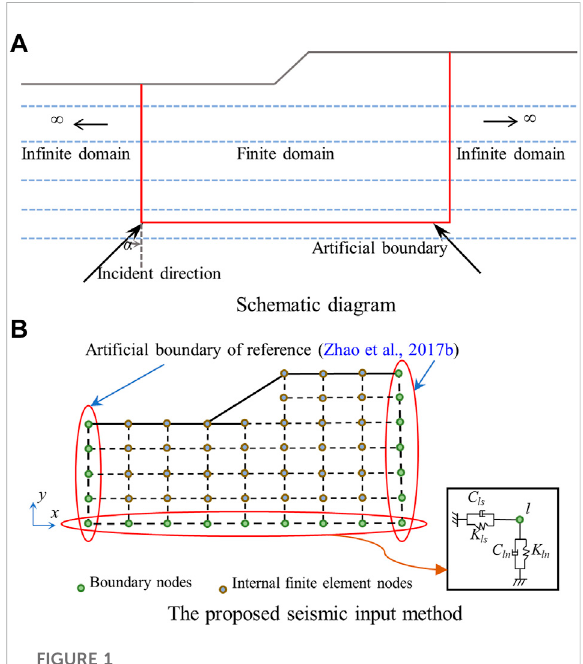
FIGURE 1 Model of a layered slope site under obliquely incident